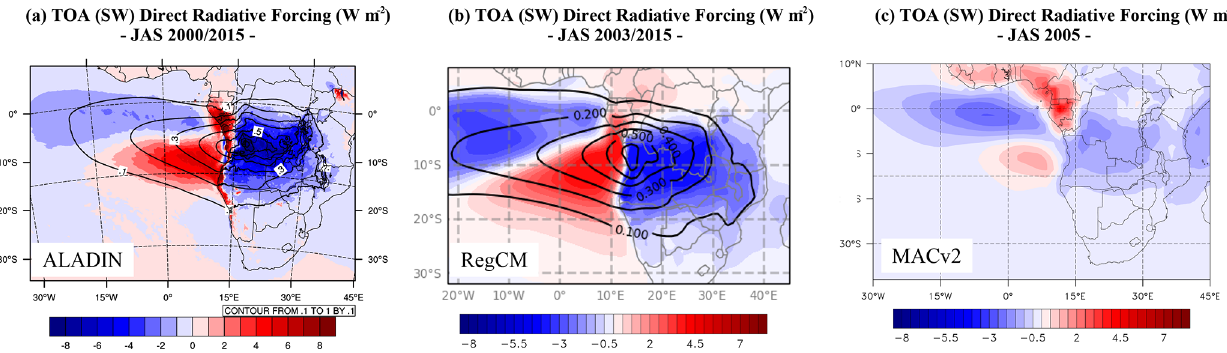
Figure 8. Seasonal-mean (JAS) BBA DRE (Wm − 2 ) exerted at TOA in the shortwave (all-sky conditions) for ALADIN ( a , period 2000– 2015), RegCM ( b , period 2003–2015) and the MACv2 climatology ( c , year 2005). The ISCCP-based cloud cover for high ( < 440hPa), middle (440–680hPa) and low ( > 680hPa) altitudes are used for the MACv2 radiative transfer calculations. The AOD of BBAs are indicated by the black